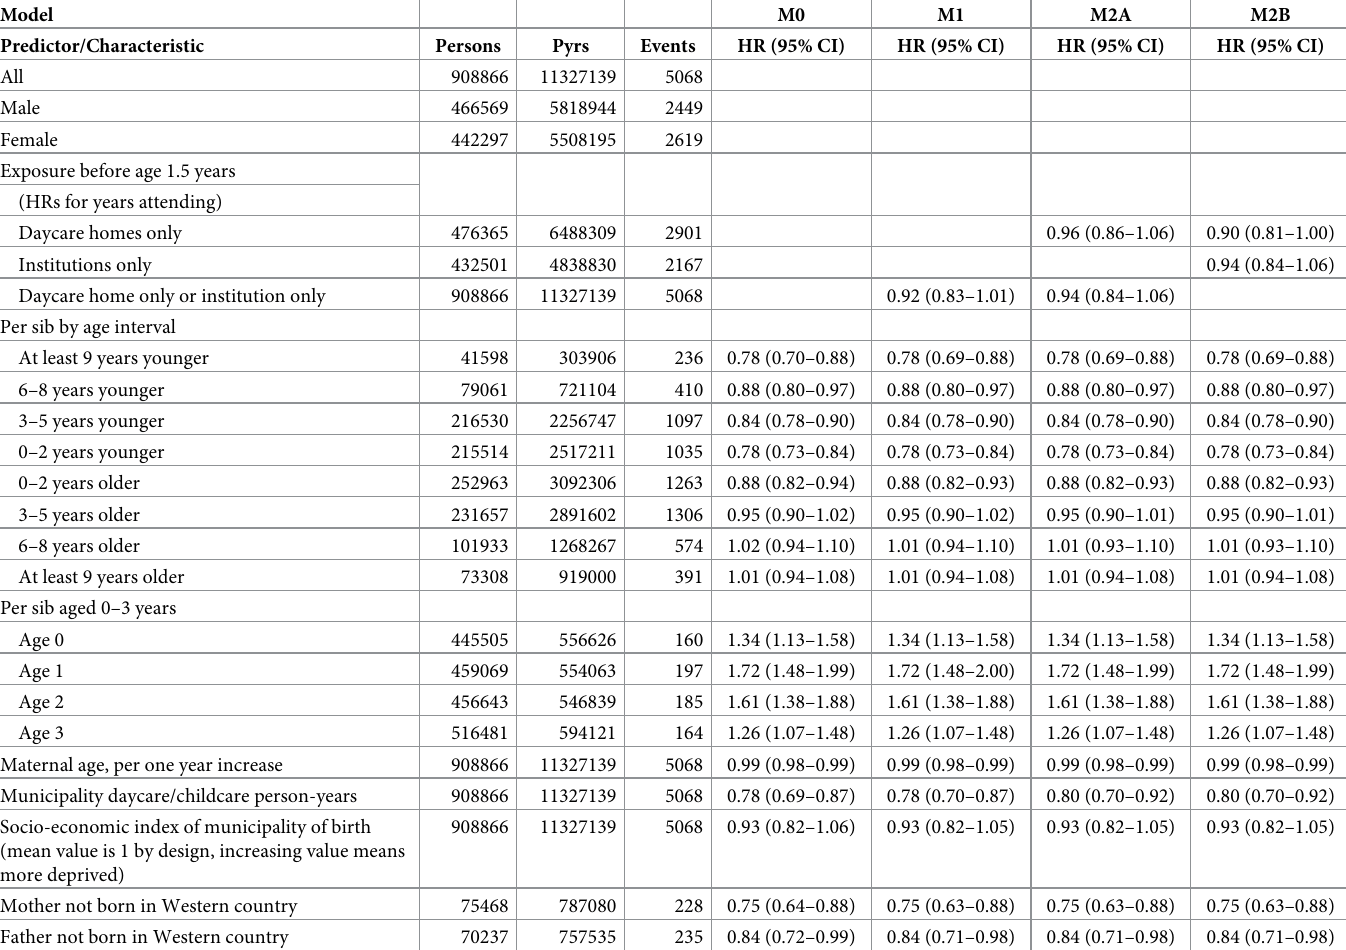
Table 1. Persons followed up (Persons), person-years (Pyrs) and incidences of IM (Events) by exposure, sex and overall in a cleanly exposed cohort of completely exposure ascertained Danish children born in July 1992 thought